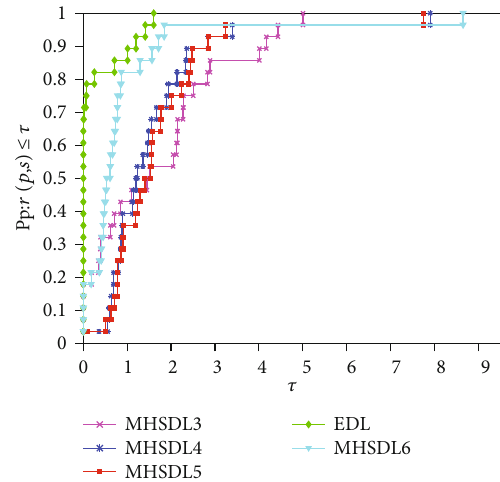
Figure 3: CPU performance pro fi le for EDL, MHSDL3, MHSDL4, MHSDL5, and MHSDL6